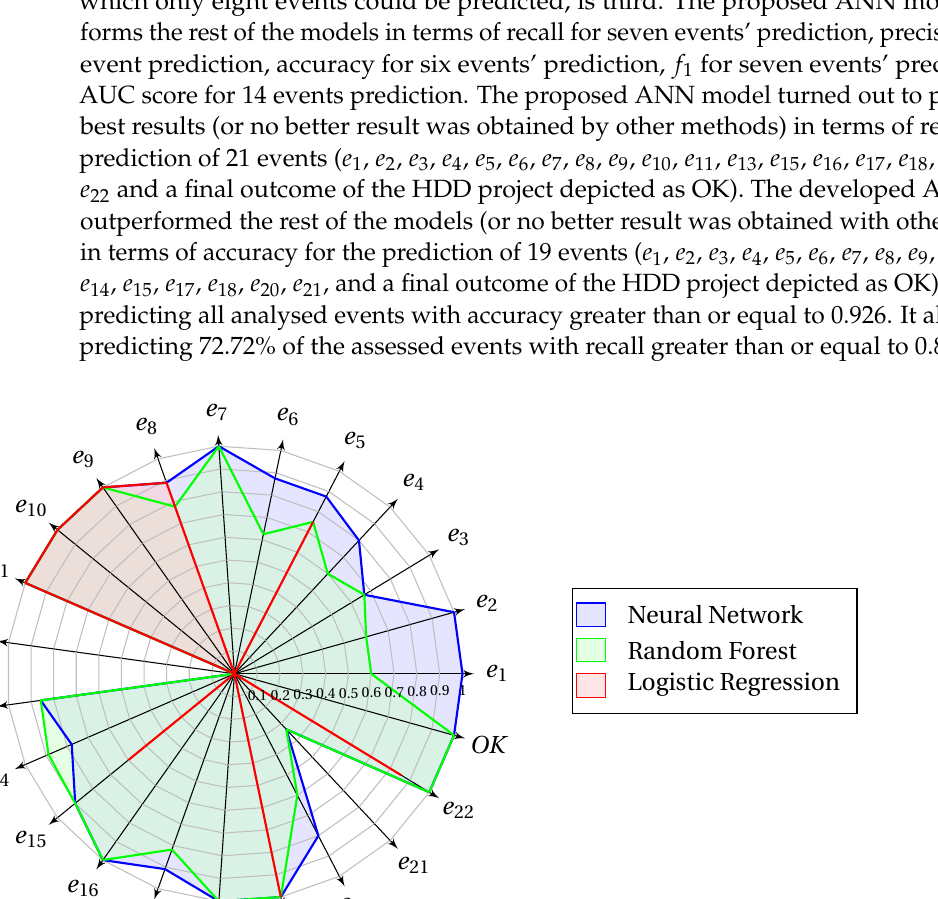
Figure 13. Comparison of the results of 3 applied methods machine learning in terms of accuracy.